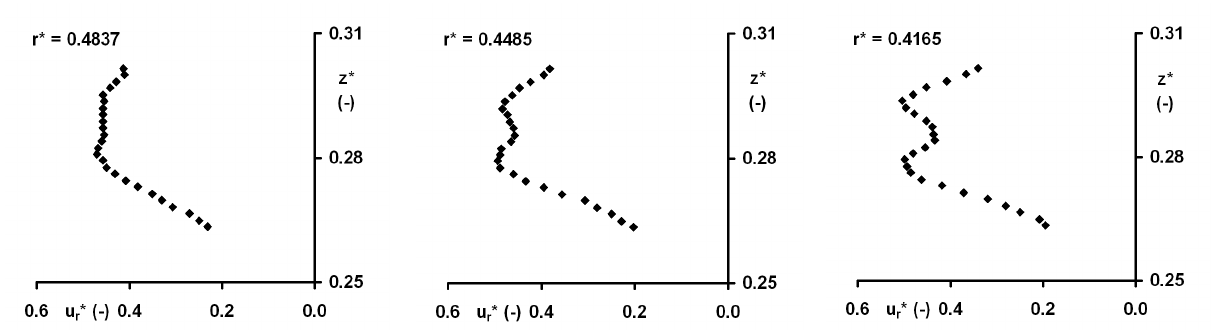
= f ( z * ) in the impeller discharge stream. r